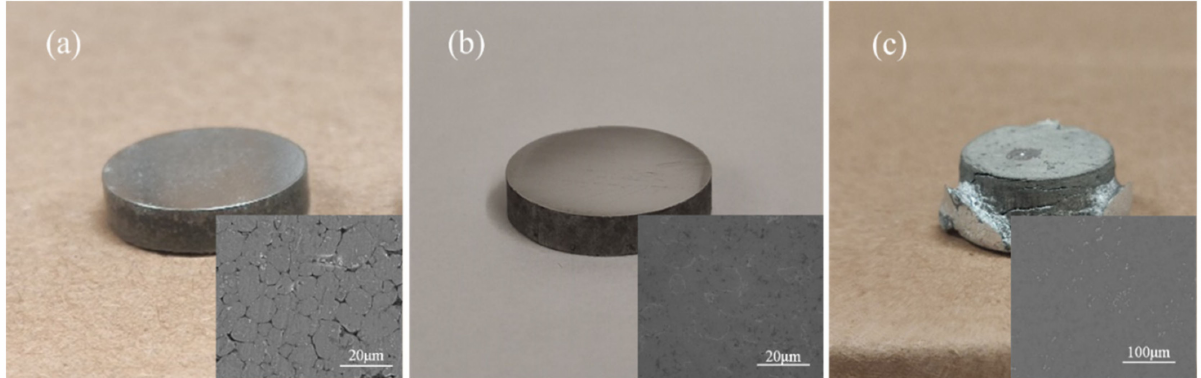
Figure 15. Sintered Al7075 specimens with different heating rates to 580 ◦ C for 20 min. ( a ) 10 ◦ C/min. ( b ) 30 ◦ C/min. ( c ) 60 ◦ C/min. The inserted SEM images indicate the microstructures of the corresponding sintered